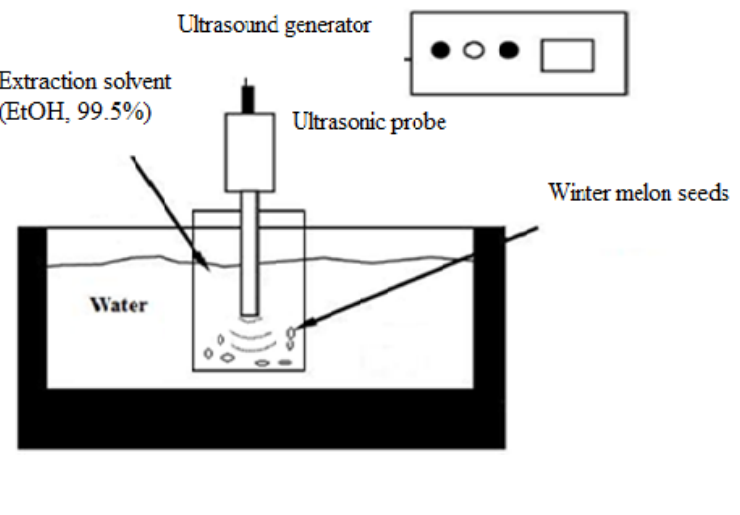
Figure 6. Scheme of experimental set-up for ultrasound-assisted extraction